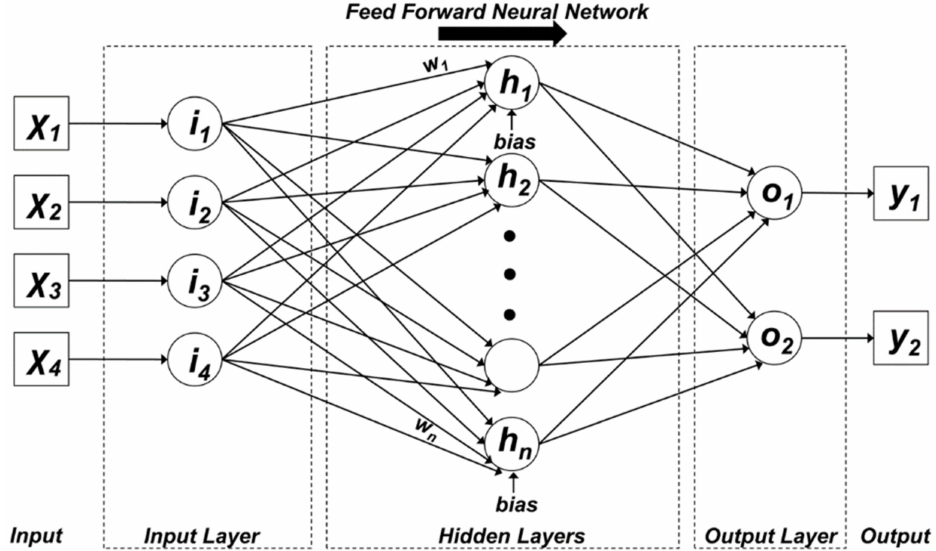
Figure 5. Feed Forward Neural Network consisting of a single hidden